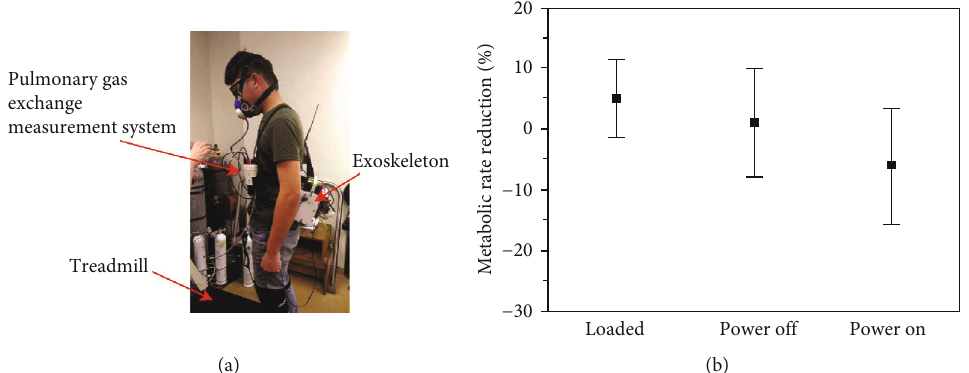
Figure 13: (a) Photograph of the metabolic tests conducted while walking on a treadmill. (b) The measured statistical distributions of the metabolic rate reduction for the cases in which loads are carried, power is switched o ff , and power is switched on. The error bar indicated one standard deviation. The metabolic rates were normalized to the case in which only the knee braces were worn (i.e., without wearing the soft